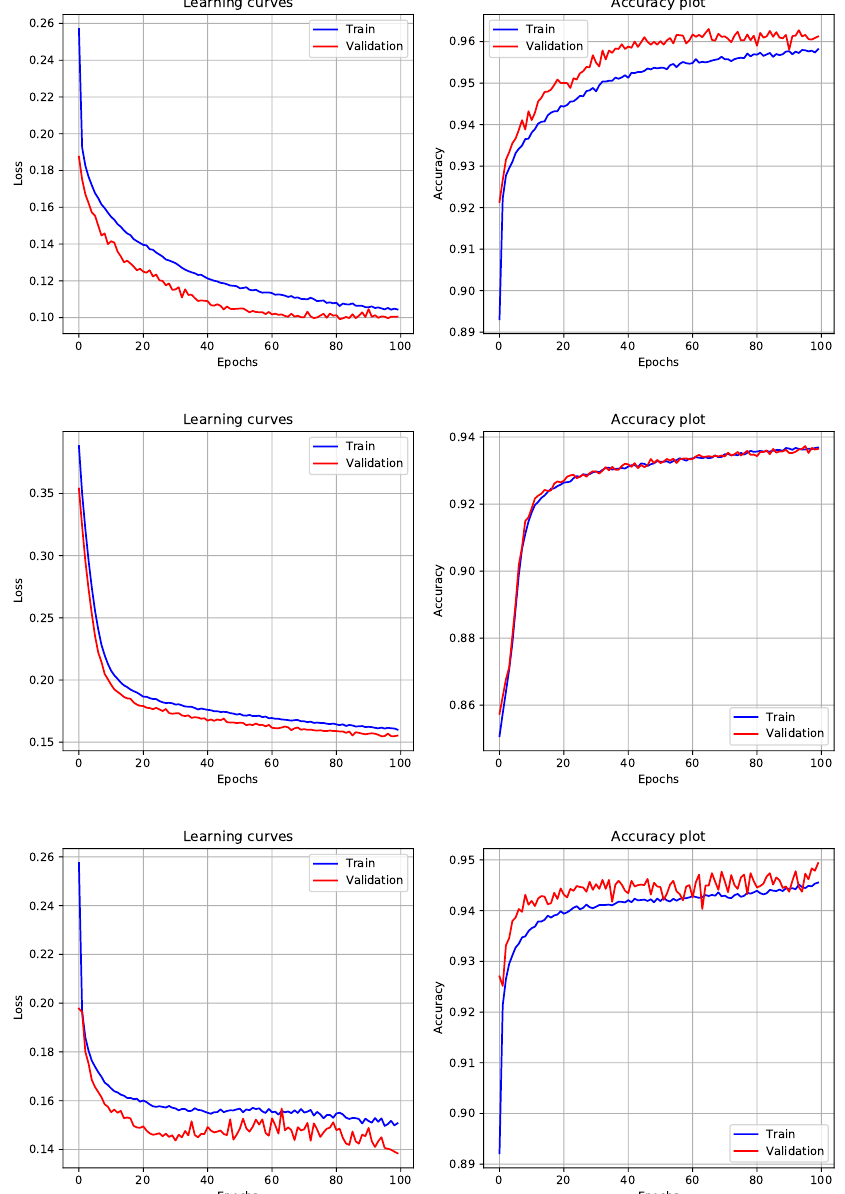
Figure 11. ( left ) Learning path of model with training and validation loss, ( right ) Accuracy plot for Stochastic Gradient Descent (SGD), Adam, and RMSprop optimizers respectively with the learning rate of 0.001 and 100